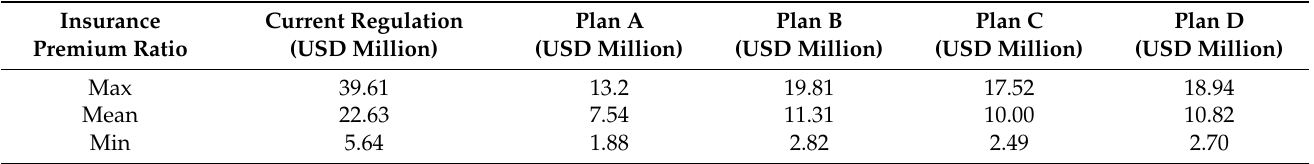
Table 5. Statistics of insurance